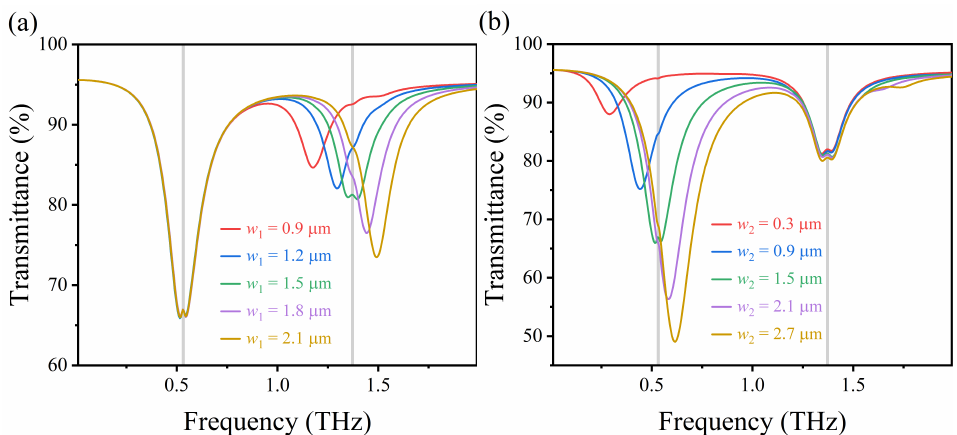
Figure 8. ( a , b ) Transmission spectra of AIGS covered with lactose at different arc widths w 1 and w 2 under vertically incident TM